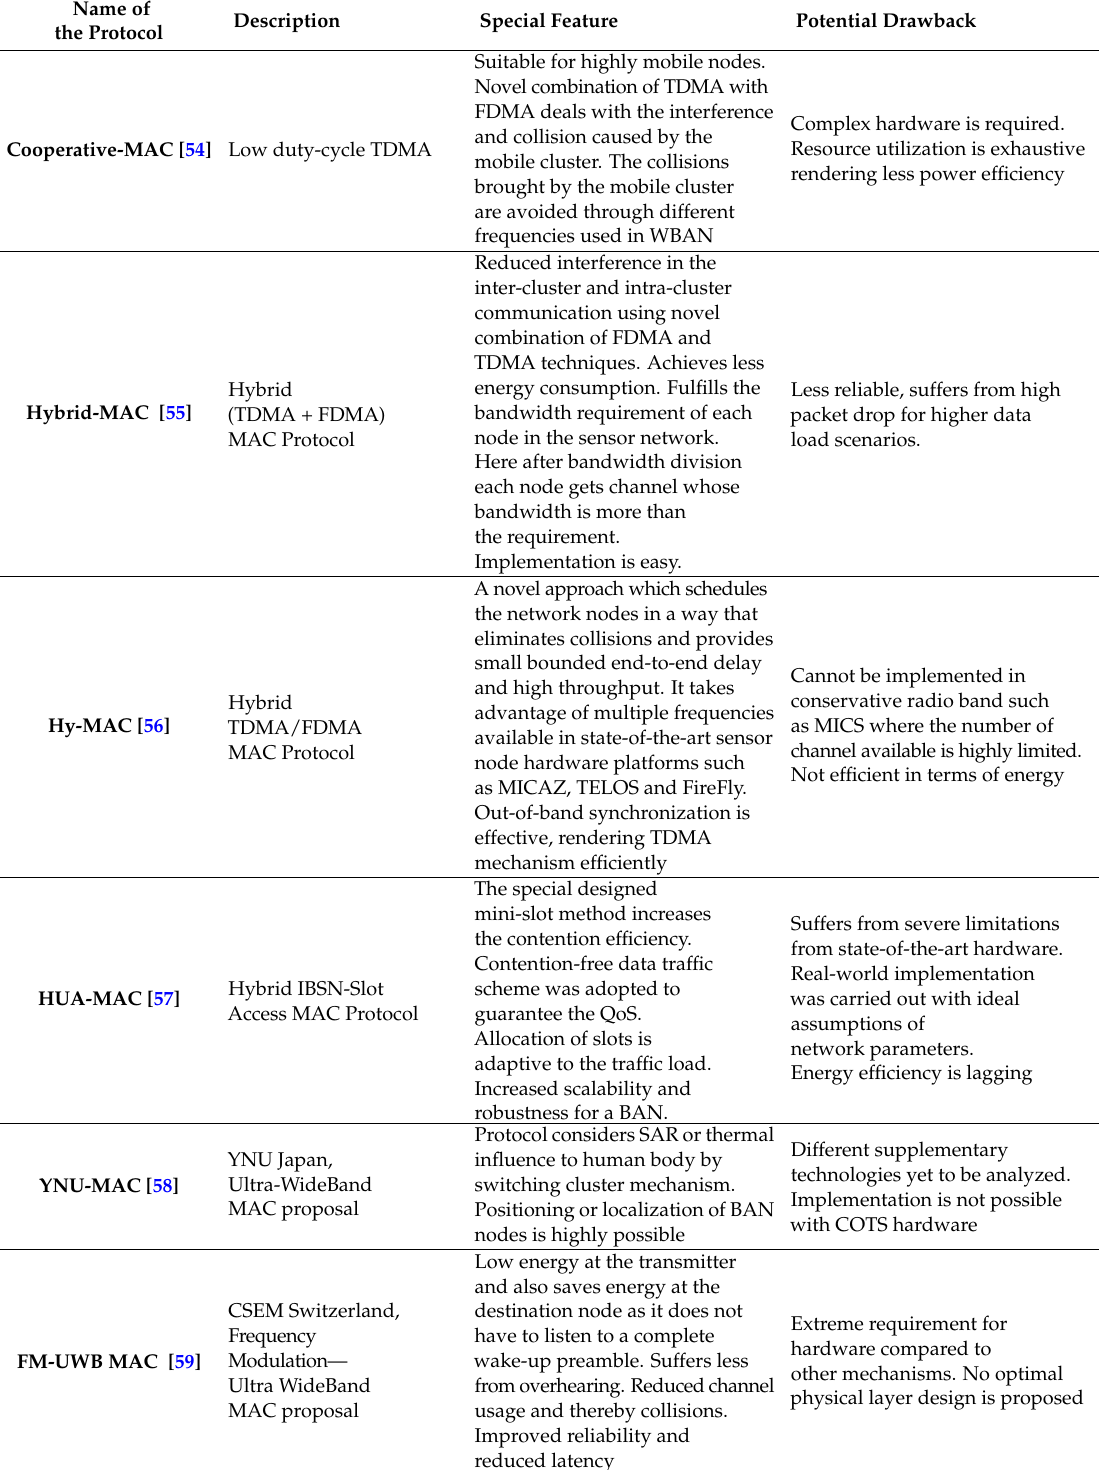
Table 9. Hybrid MAC protocols without WuR and their drawbacks for